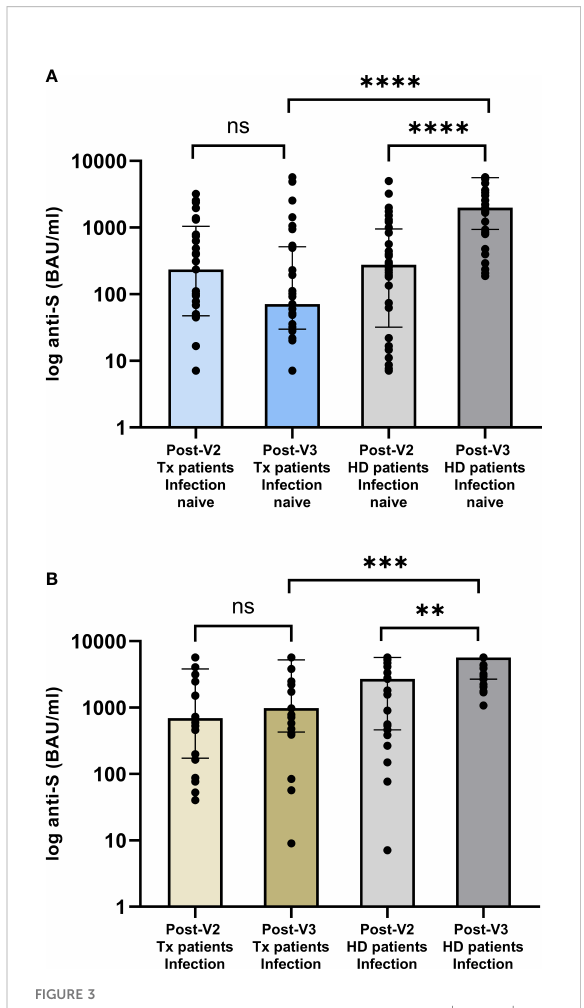
FIGURE 3 Comparison of serological responses following (A) 2 nd and 3 rd vaccine dose in patients transplanted following (A) 2 nd vaccine versus those remaining on the waitlist by infection status. In infection naïve individuals, there was no difference between post- V2 anti-concentrations whilst all were on the waitlist, p=0.97. Post-V3, anti-S concentrations were signi fi cantly higher in those remaining on the waitlist compared with the V2-group who were subsequently transplanted, median anti-S of 1982 (936-5593) and 71 (30-516) BAU/ml respectively, p<0.0001. (B) In patients with prior infection, post-V3 concentrations were signi fi cantly higher in dialysis versus transplant patients at 5680 (2681-5680) and 983 (427-5214) BAU/ml respectively, p=0.0006. ****p<0.0001, *** p<0.001, **p<0.01. ns, non-signi fi